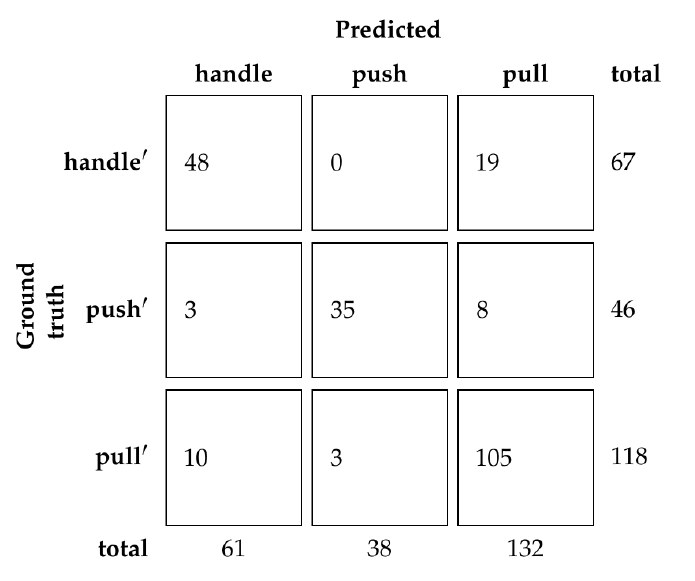
Figure 11. Confusion matrix of classification of the test set with human demonstration.